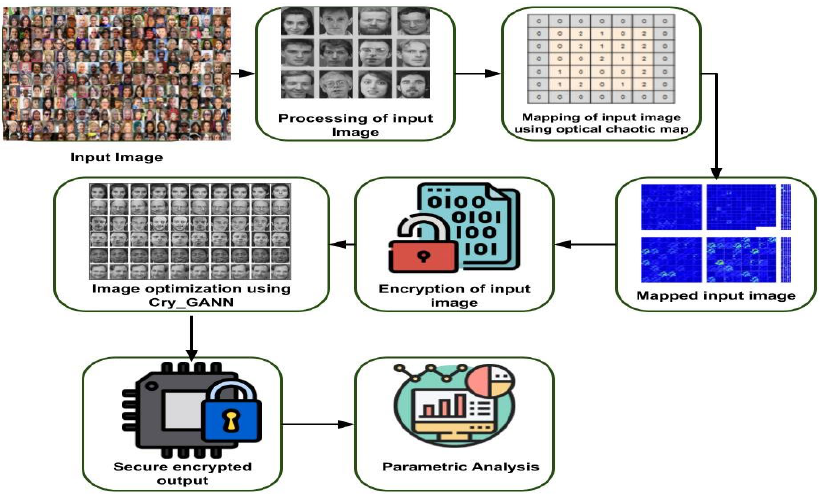
Figure 2. Overall proposed